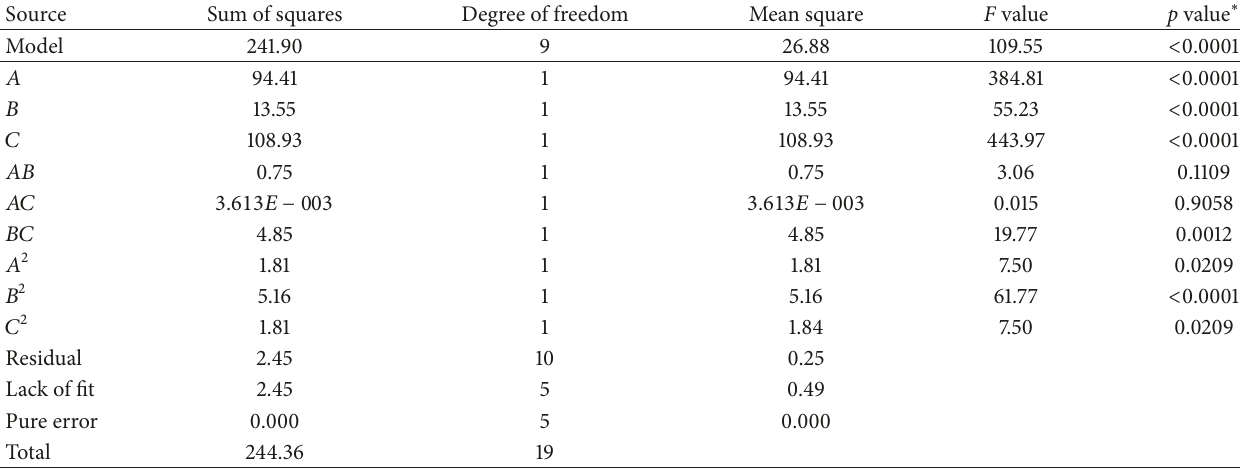
Table 3: ANOVA of WL rate regression model for strawberry osmotic